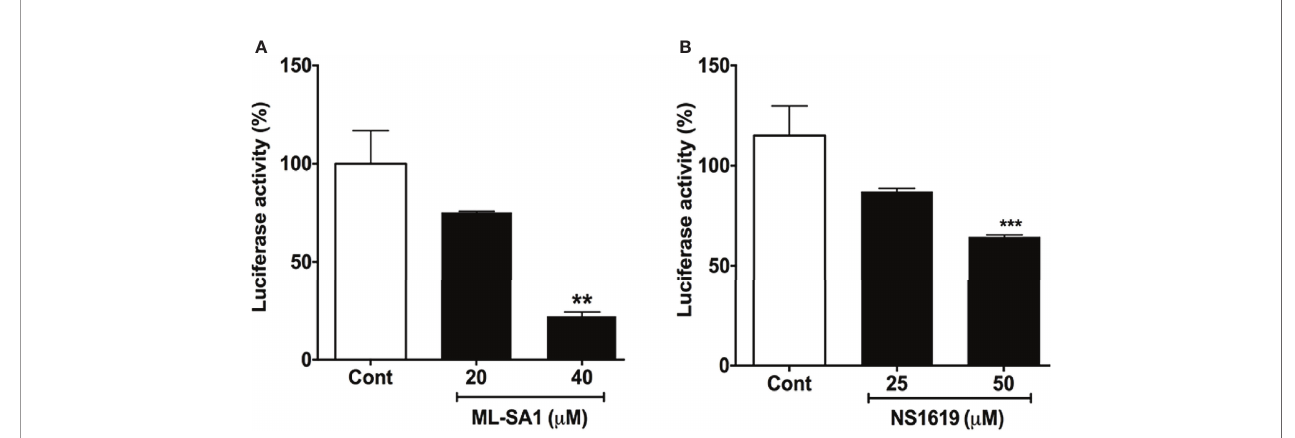
FIGURE 5 | ML-SA1 and NS1619 attenuated SARS-CoV-2 spike protein-mediated entry of pseudo-SARS-CoV-2: (A) ML-SA1 treatment (40 µM for 18 h) signi fi cantly attenuated SARS-CoV-2 spike protein-mediated entry of pseudo-SARS-CoV-2 as indicated by decreases in luciferase activity in Calu-3 cells (n = 3, **p<0.01). (B) NS1619 treatment (50 µM for 18 h) signi fi cantly attenuated SARS-CoV-2 spike protein-mediated entry of pseudo-SARS-CoV-2 as indicated by decreases in luciferase activity in Calu-3 cells (n = 3,